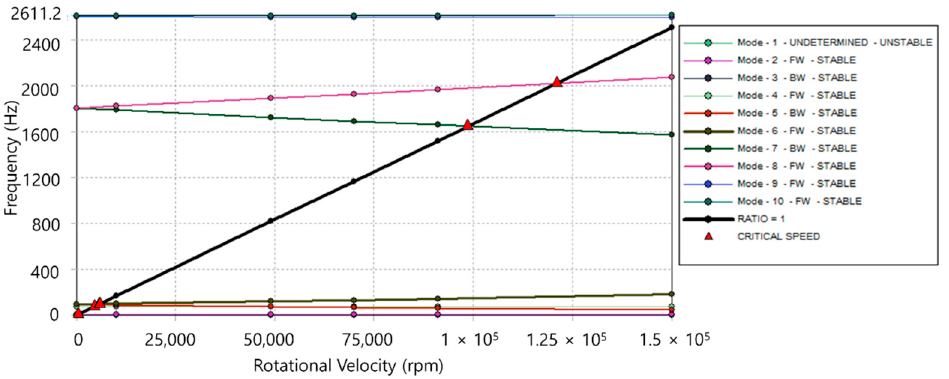
Figure 12. Campbell diagram of test compressor.